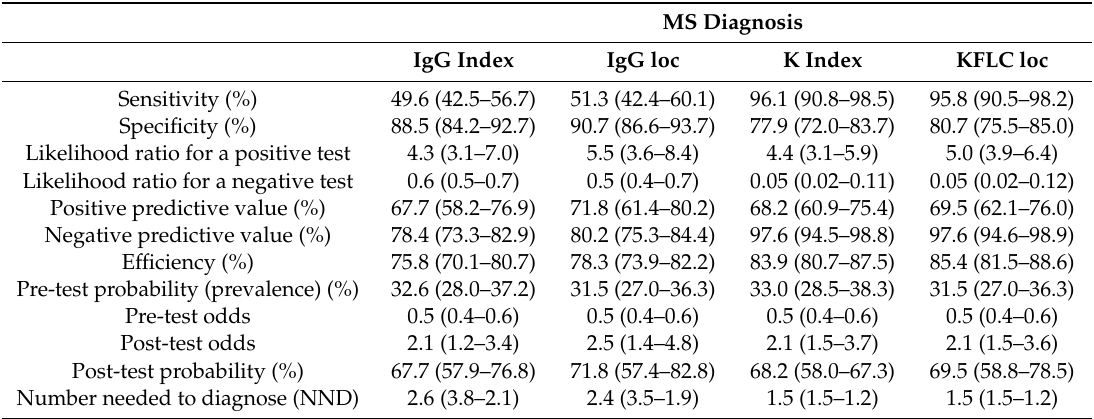
Table 3. Diagnostic performances of IgG index, IgG loc, K index and K loc for MS